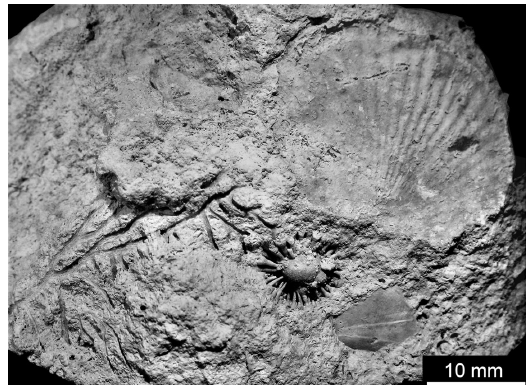
Fig. 14. Natural surface of a type 2A boulder. Left: cast of an undetermined cryptostomate bryozoan; bottom right: Coelosphaeridium sphaericum and a sclerite of a machaeridian; top right: Cyrtonotella sp., exterior mould of dorsal valve. RGM 1317651,